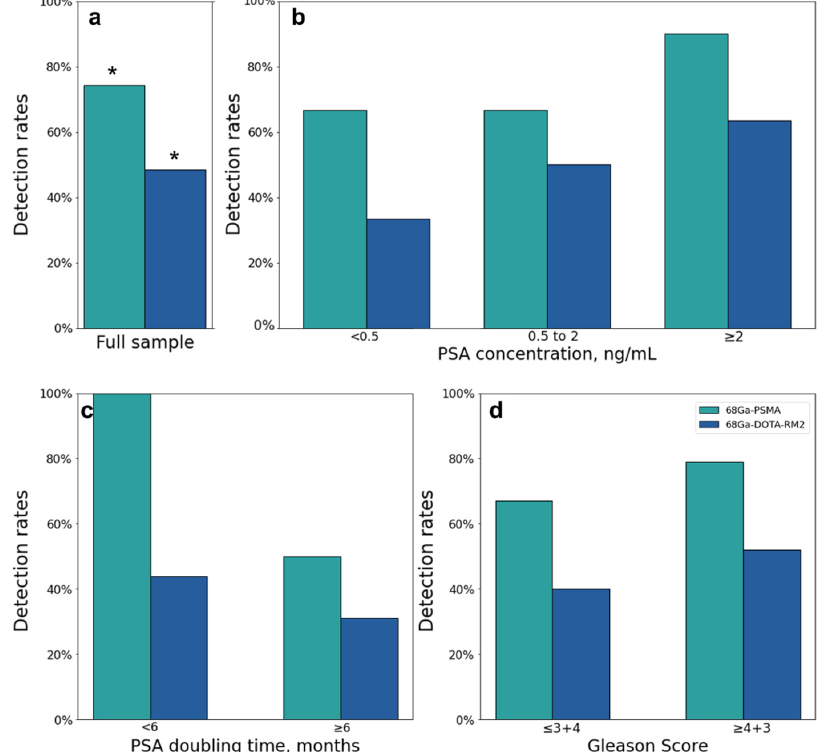
Figure 4. 68 Ga-PSMA and 68 Ga-DOTA-RM2 PET/MRI findings. ( a ): 68 Ga-PSMA and 68 Ga-DOTA- RM2 detection rates; ( b ): 68 Ga-PSMA and 68 Ga-DOTA-RM2 detection rates stratified by different PSA levels at time of scans; ( c ): 68 Ga-PSMA and 68 Ga-DOTA-RM2 detection rates stratified by PSA DT; ( d ): 68 Ga-PSMA and 68 Ga-DOTA-RM2 detection rates stratified by GS prior to radical treatment. * = p < 0.05.